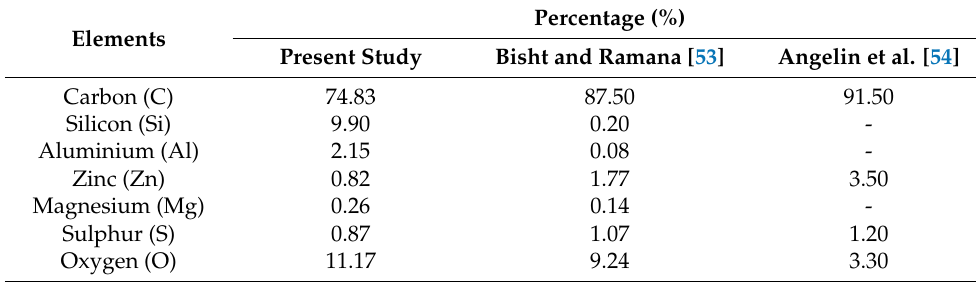
Table 3. Chemical properties of rubber waste